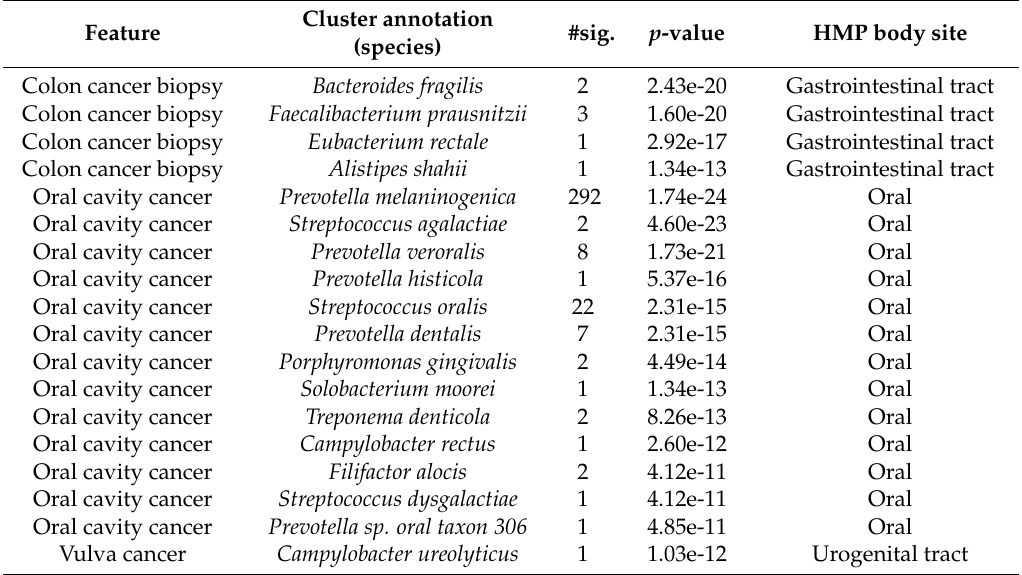
Table 2. Taxonomical characterisation of certain biologically associated clusters. The clusters are significantly associated with lowest p -values to biological features and the species annotations are described by HMP. In cases where several clusters shared the annotated species, the lowest p -value of the associations is given #sig : number of significant